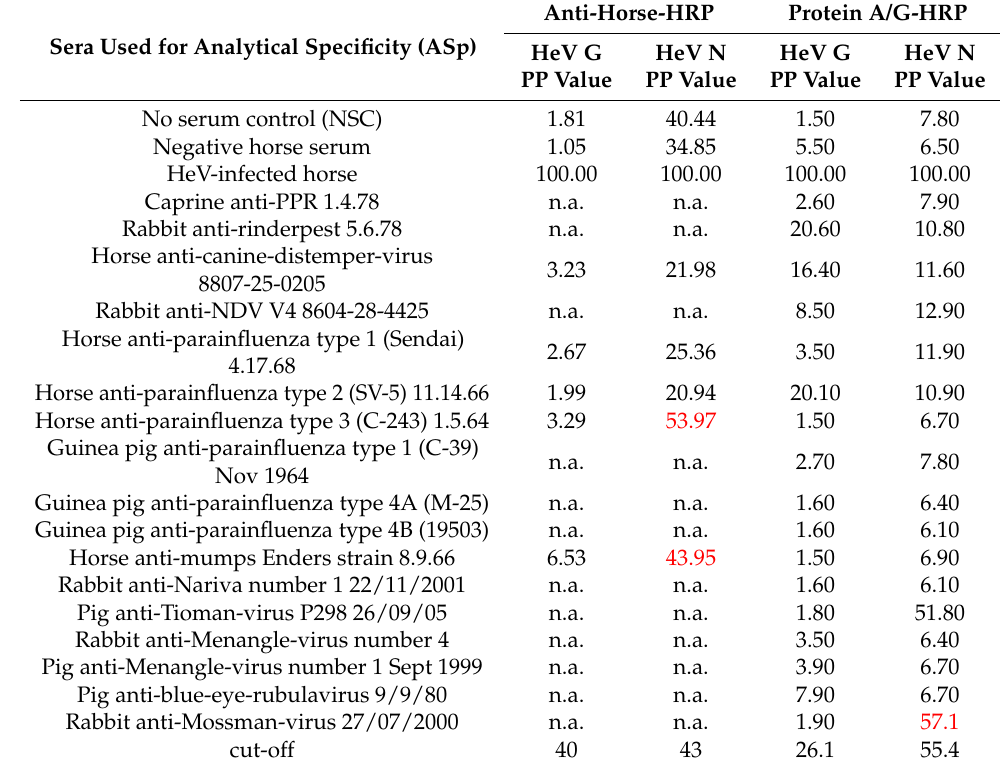
Table 5. PP results of analytical specificity (ASp) for HeV-G and HeV-N assays with 17 sera from different species containing antibodies against different paramyxoviruses. Positive results are printed in red, including one horse anti-parainfluenza Type 3 virus and one horse anti-mumps-virus serum when developed with the anti-horse conjugate, and one rabbit anti-Mossman-virus serum when developed with Protein A/G. n.a.—not available. Anti-Horse-HRP Protein A/G-HRP Sera Used for Analytical Specificity (ASp) HeV G PP Value No serum control